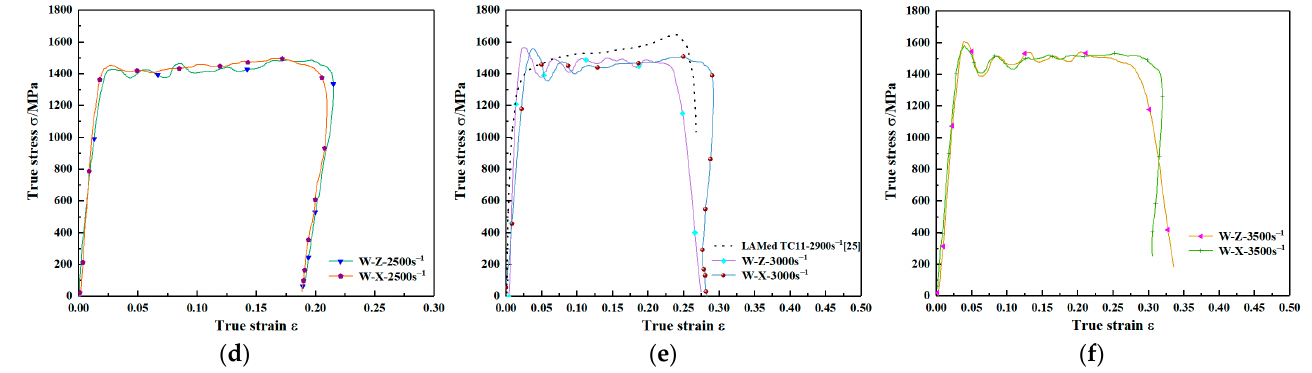
Figure 9. Stress–strain curves for different specimens at the same strain rate under dynamic loading conditions. ( a ) Strain rate of 700 s − 1 . ( b ) Strain rate of 1500 s − 1 . ( c ) Strain rate of 2000 s − 1 . ( d ) Strain rate of 2500 s − 1 . ( e ) Strain rate of 3000 s − 1 . ( f ) Strain rate of 3500 s − 1 .